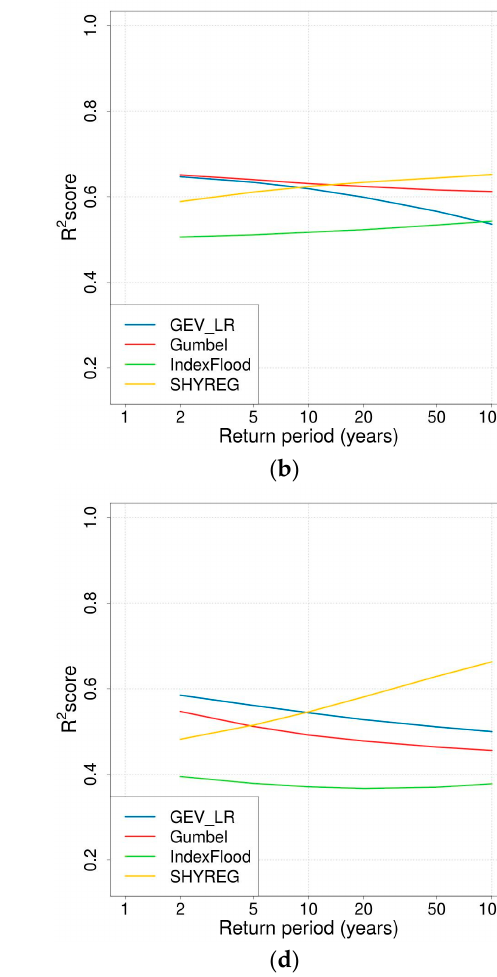
Figure 4. R 2 values for the different quantiles and the different regionalised FFAs. ( a ) All of France; ( b ) Plains zone; ( c ) Mediterranean zone; ( d ) Mountainous zone.